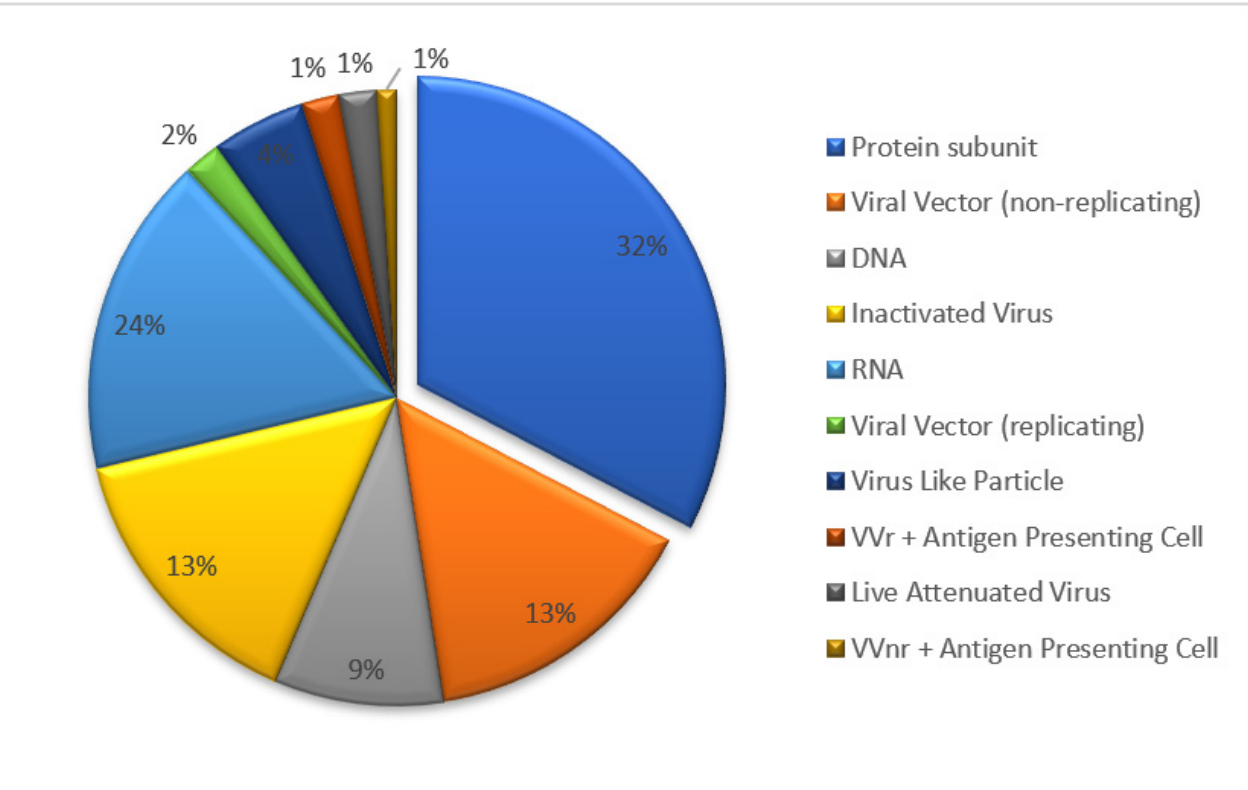
Figure 1. The types and proportions of COVID-19 vaccine undergoing clinical trial.